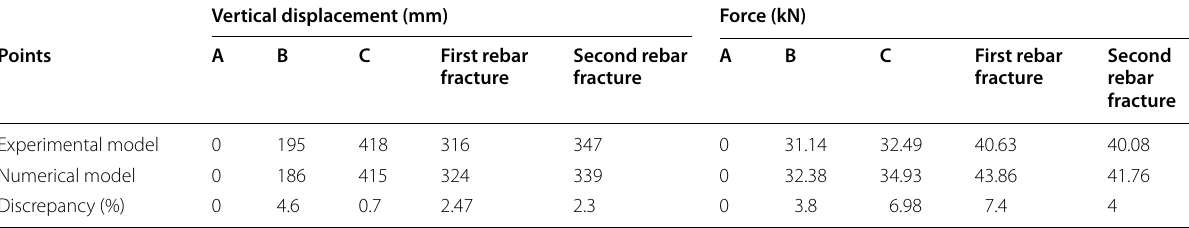
Table 3 The specifications of the important points in the experimental and numerical